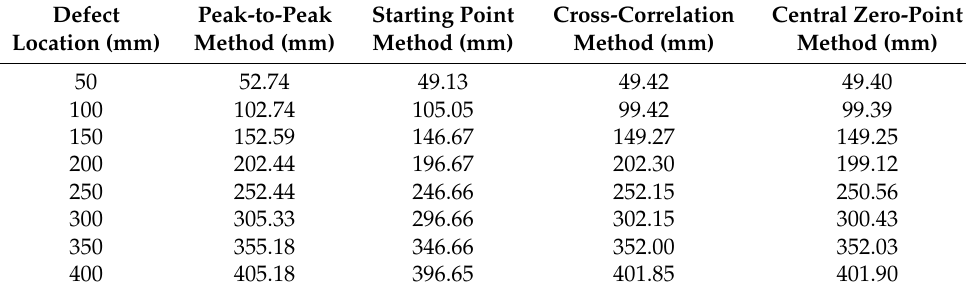
Table 4. Defect localization measurement data of four